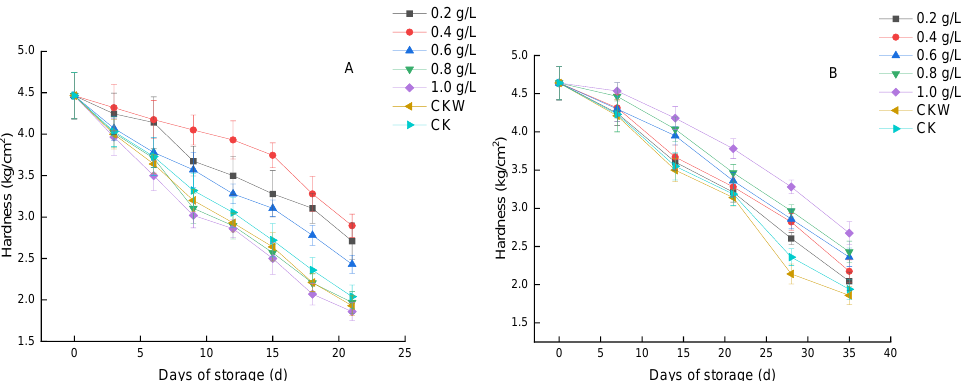
Figure 5. Effects of different Lycium barbarum leaf extract concentrations on the firmness of cherry tomatoes at 20 °C ( A ) and 5 °C ( B ).